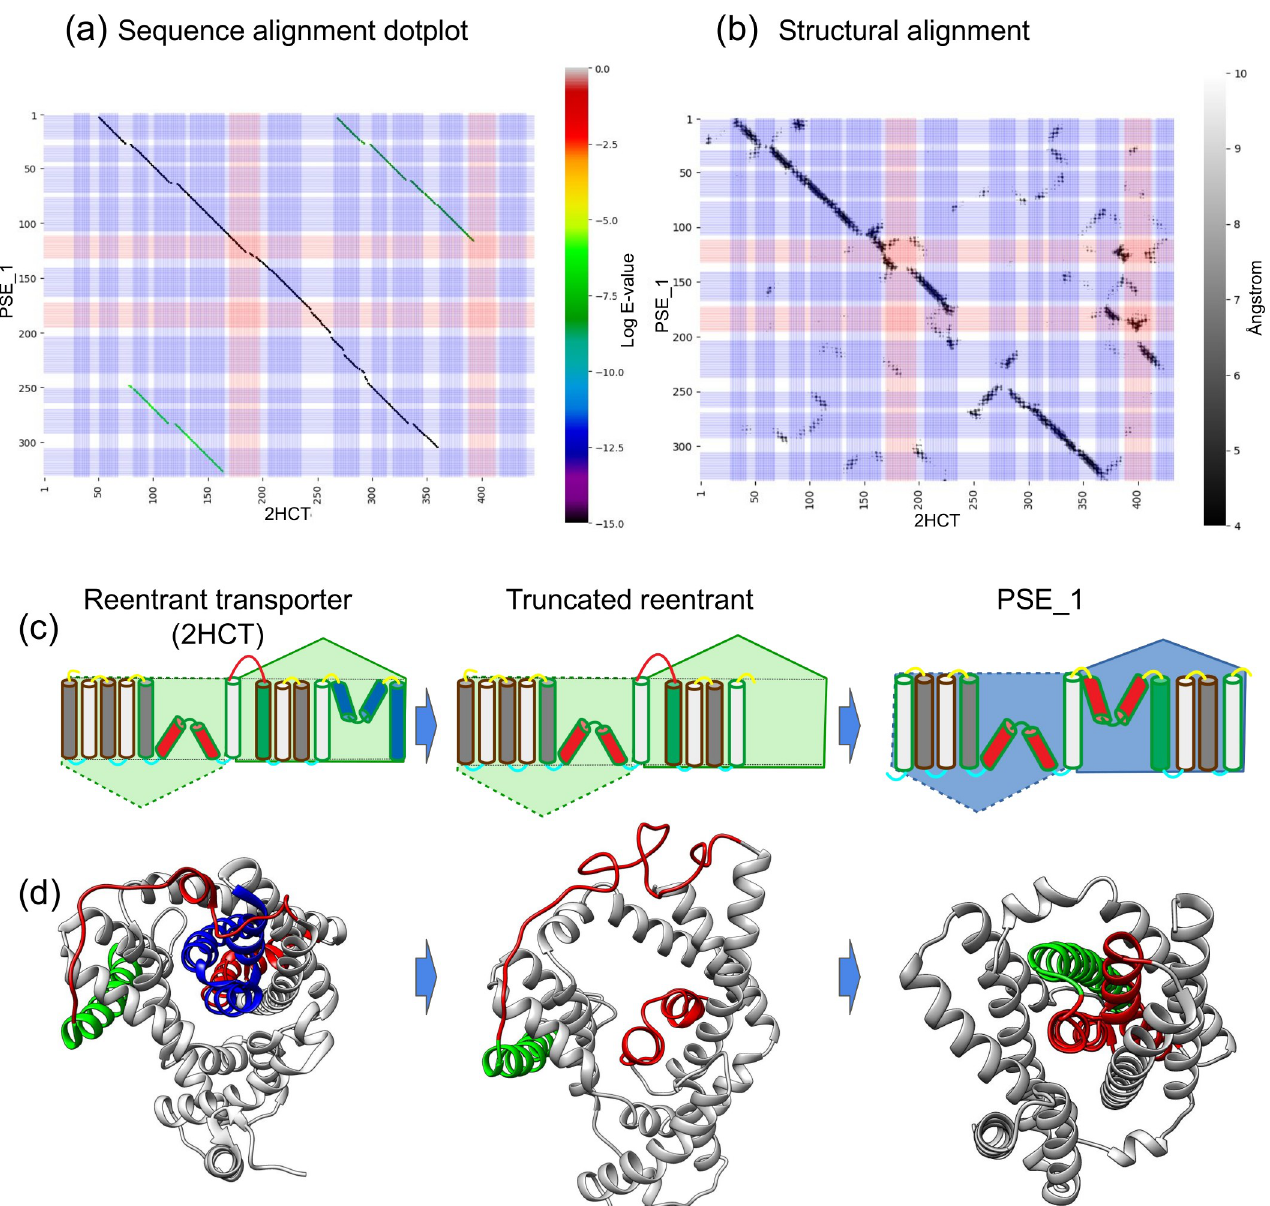
Fig 4. Transition and alignments between 2HCT and PSE_1. a) A “Dotplot” between PSE_1 and 2HCT: The blue lines represent the TM helices and the red one the reentrant helices, the color spectra show the Log of E-value of the alternative alignments. b) The panel shows an all-vs-all distance matrix between the trRosetta models and the 2HCT PDB structure 5a1s. The greyscale indicates the distance between the mutual distances between the protein residues from 4 to 10 Å . b) Schematic representation of the topology of the protein with its corresponding structure below. The TM helices (in-out) and (out-in) are colored white and grey respectively. The reentrant helices after the transition are colored red. The helix 7 that changes position after the transition is colored green. The part of 2HCT putatively lost in the truncation is colored blue. c) Corresponding protein structures. PSE_1 family and the CPA-reentrant fold-type family, Citrate Symporter family (2HCT). From the alignment between PSE_1 and 2HCT (identity 14.5%, 316 aligned positions), it can be speculated that PSE is a truncated version of 2HCT , Fig 4A and 4B. The sequence alignment shows that PSE_1 aligns from TM2 to TM10 of 2HCT , i.e., both scaffold domains as well as the N-terminal core domain are conserved (except TM1) but only the first TM helix of the second